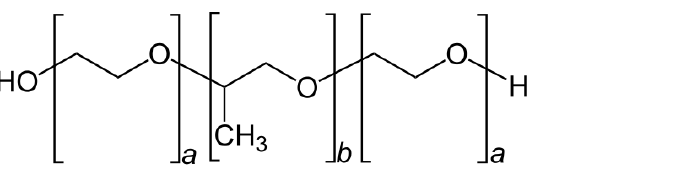
Figure 2. Structure of phytantriol.